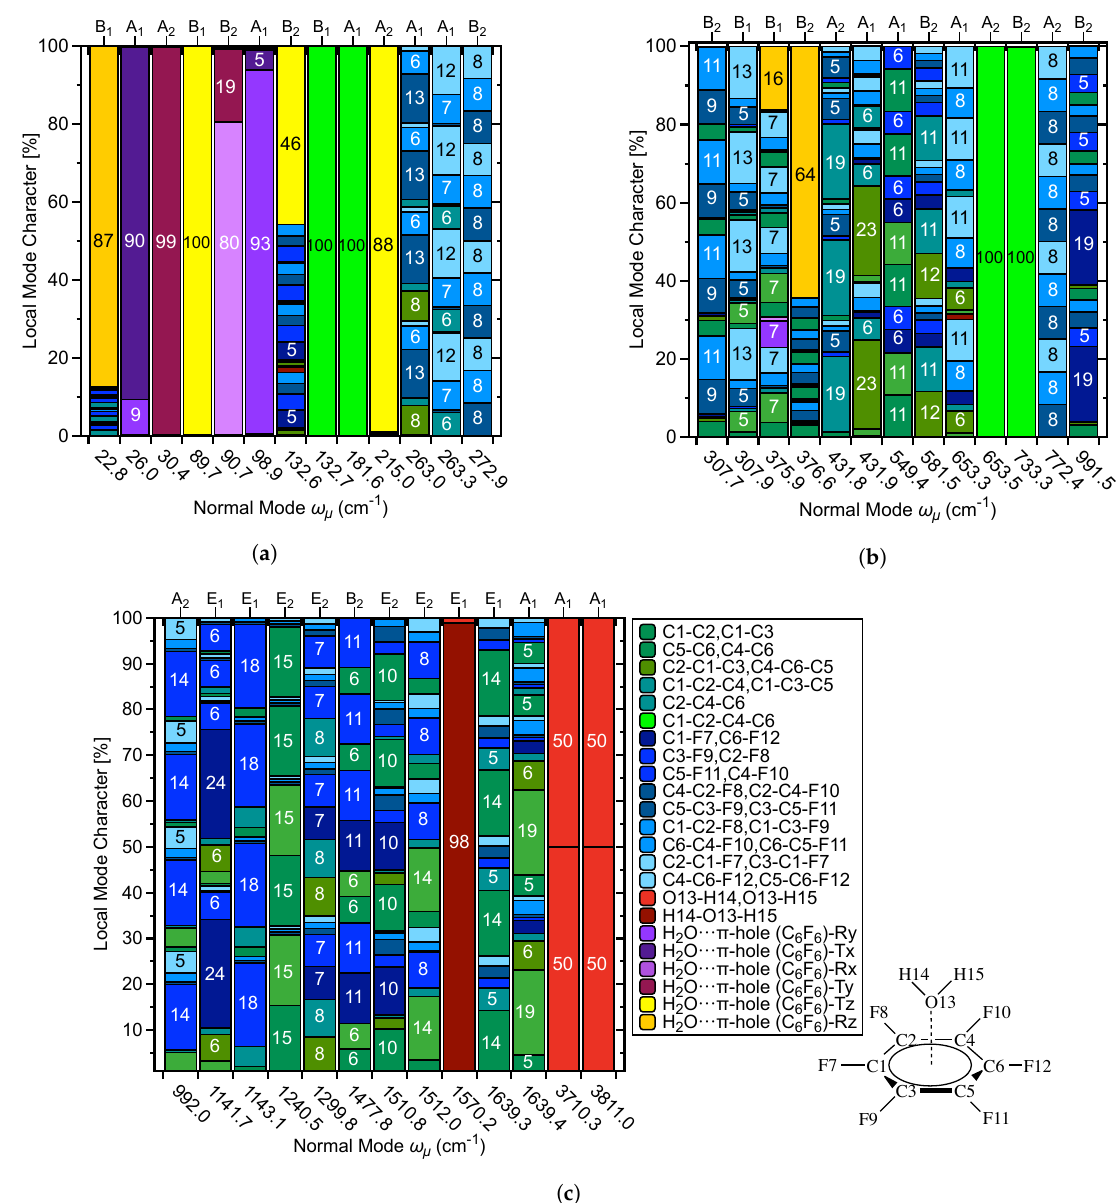
Figure 10. Decomposition of normal vibrational modes into % LVM contributions for the H π –hole system 1 ; ( a ) % LVM contributions to normal vibrational modes 1–13, ( b ) % LVM